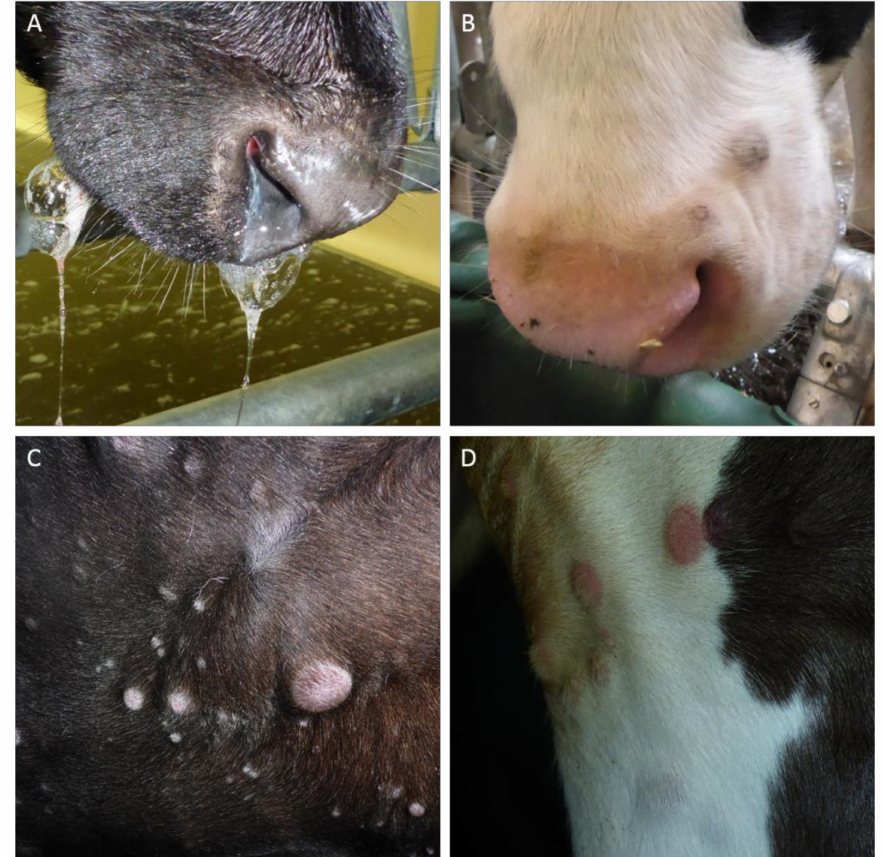
Figure 2. Clinical reactions of cattle following experimental infection with LSDV-strain “Macedonia2016”. In cattle with severe clinical signs, excessive salivation and nasal discharge ( A ), as well as sporadic to generalized skin nodules ( B – D ), could be